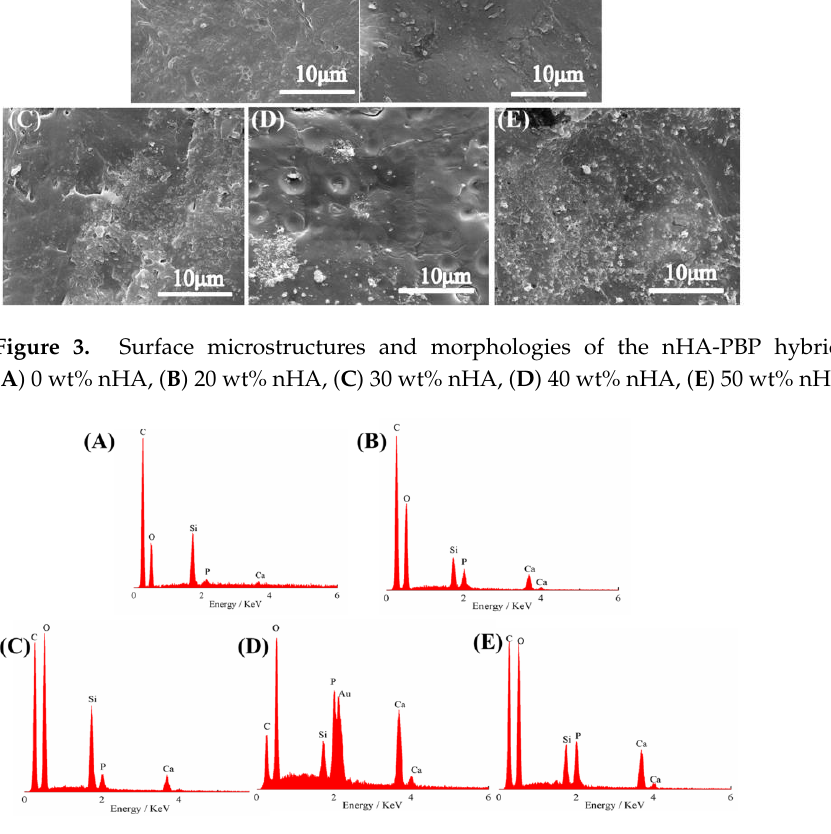
Figure 3. Surface microstructures and morphologies of the nHA-PBP hybrid membranes. ( A ) 0 wt% nHA, ( B ) 20 wt% nHA, ( C ) 30 wt% nHA, ( D ) 40 wt% nHA, ( E ) 50 wt% nHA. Figure 4. EDS analysis spectra of the nHA-PBP hybrid membranes. ( A ) 0 wt% nHA, ( B ) 20 wt% nHA, ( C ) 30 wt% nHA, ( D ) 40 wt% nHA, ( E ) 50 wt% nHA.